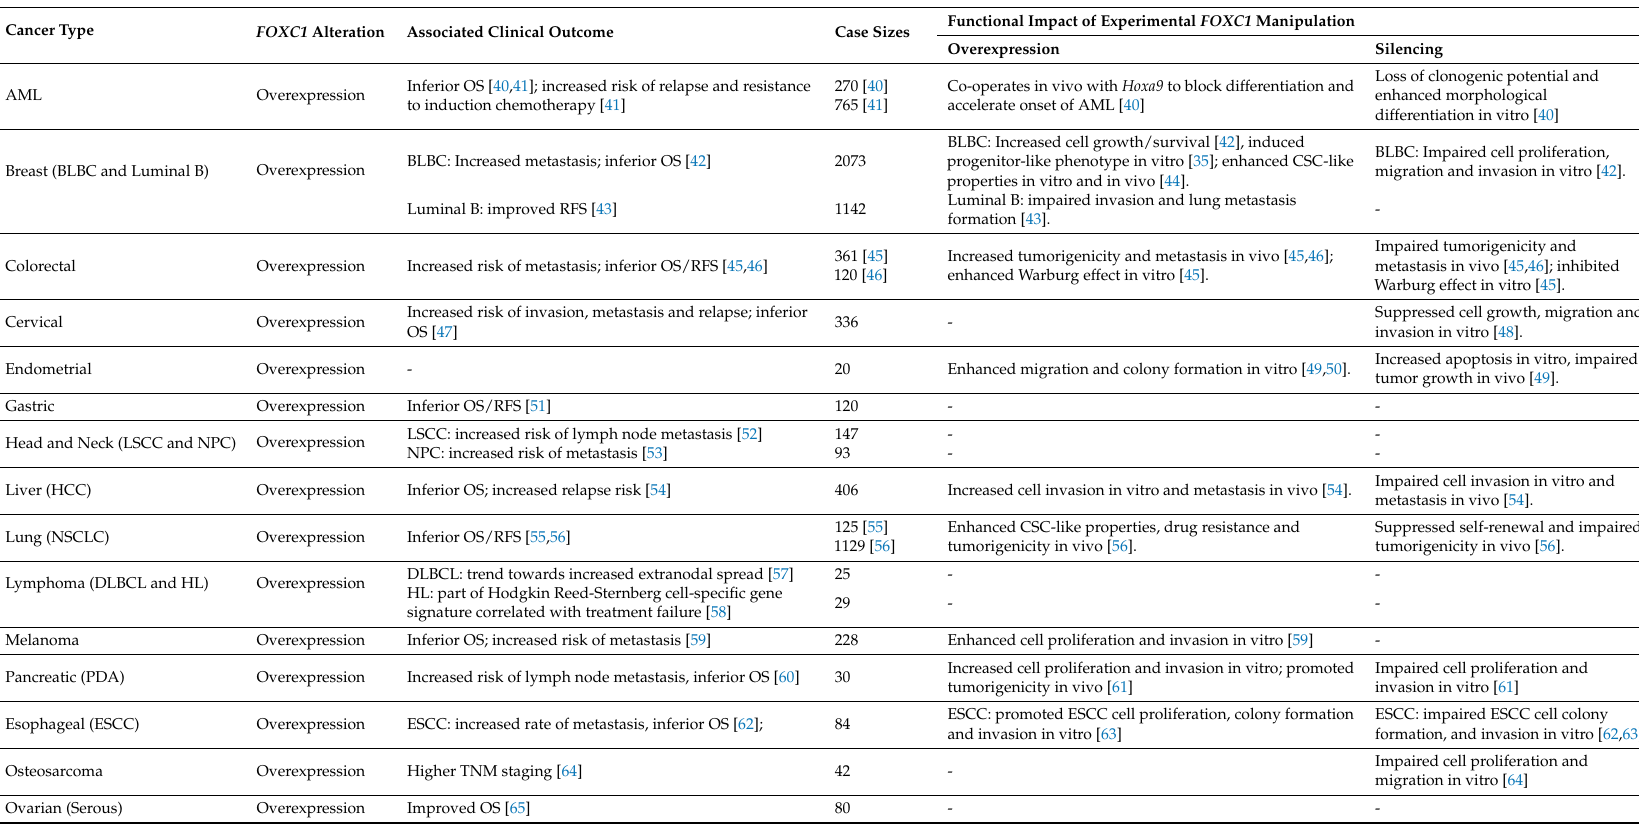
Table 1. A summary of FOXC1 alterations in cancer, associated clinical outcomes, and functional consequences of experimental manipulation of FOXC1 expression. Cancer